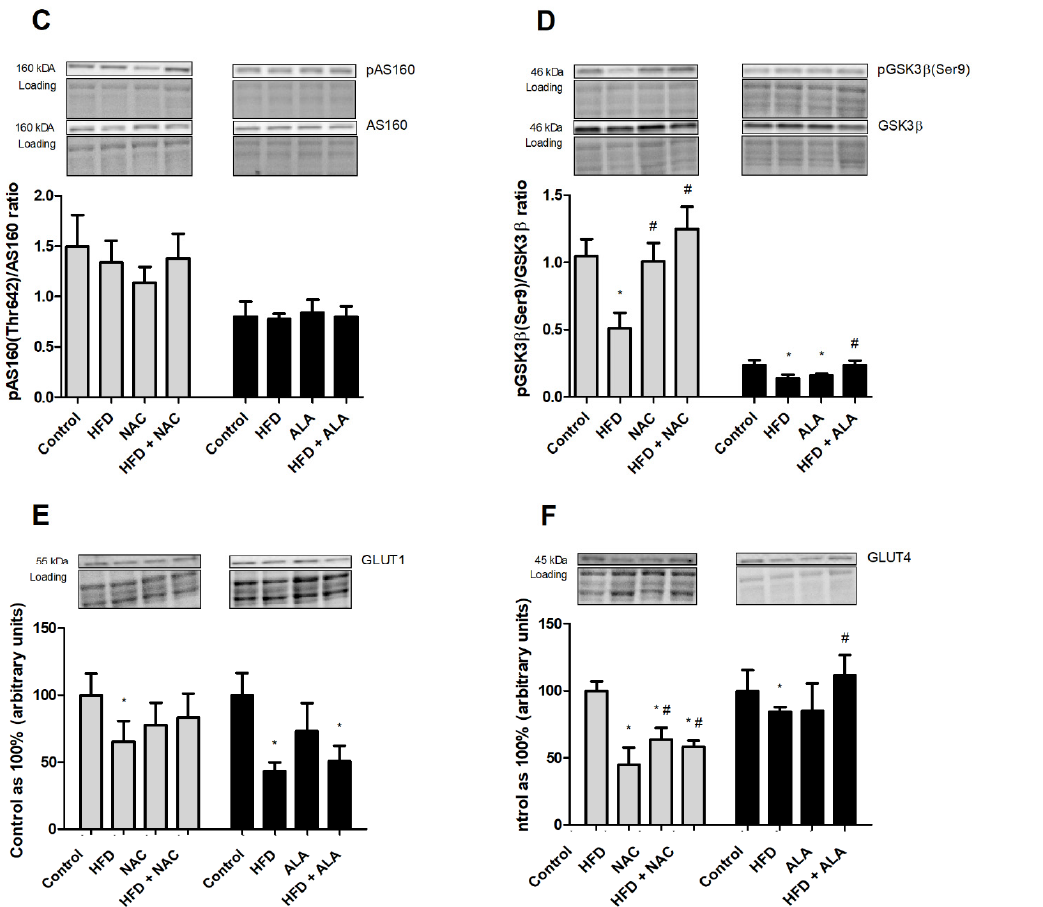
Figure 6. The phosphorylation ratio of the protein from the insulin signaling pathway, i.e., ( A ) insulin receptor sub- strate 1 (IRS1; pIRS1(Ser302)/IRS1 ratio), ( B ) protein kinase B (Akt; pAkt(Ser473)/Akt ratio), ( C ) AS160 protein (AS160; pAS160(Thr642)/AS160 ratio), ( D ) glycogen synthase kinase 3 β (GSK3 β ; pGSK3 β (Ser9)/GSK3 β ratio), as well as the total expression of ( E ) glucose transporter 1 (GLUT1), ( F ) glucose transporter 4 (GLUT4) after eight-week treatment of n-acetylcysteine (NAC) or α -lipoic acid (ALA) in the left ventricle of rats fed a standard diet (Control group) or high-fat diet (HFD group). The data are expressed as the mean values ± SD and are based on six independent determinations ( n = 6). * p < 0.05 significant difference vs. corresponding Control group; # p < 0.05 significant difference vs. corresponding high-fat diet